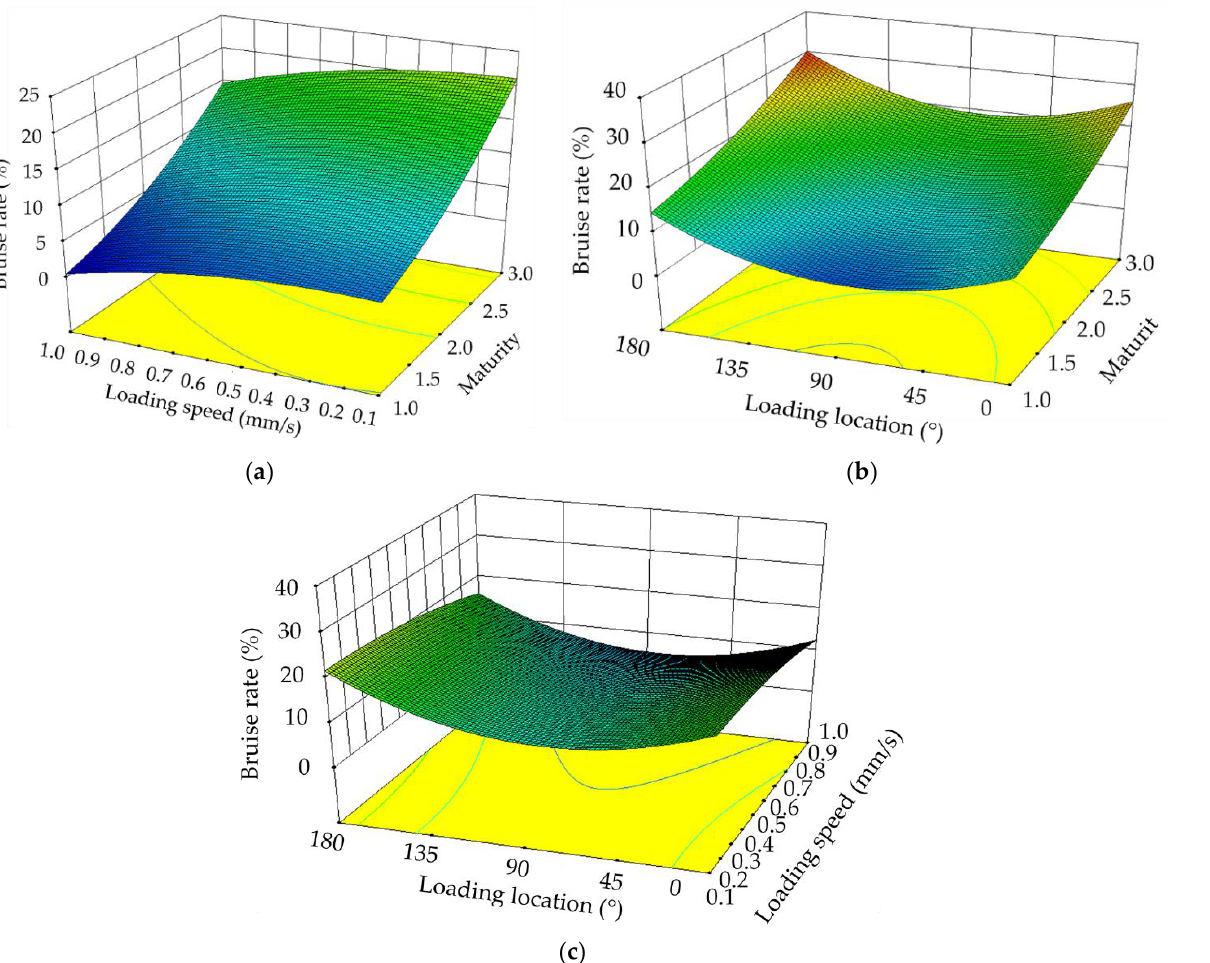
Figure 6. Response surface of influencing factors. Response surface for the effect of loading speed and maturity on bruising rate ( a ), response surface for the effect of loading position and maturity on bruising rate ( b ), and response surface for the effect of loading position and loading speed on bruising rate ( c ).